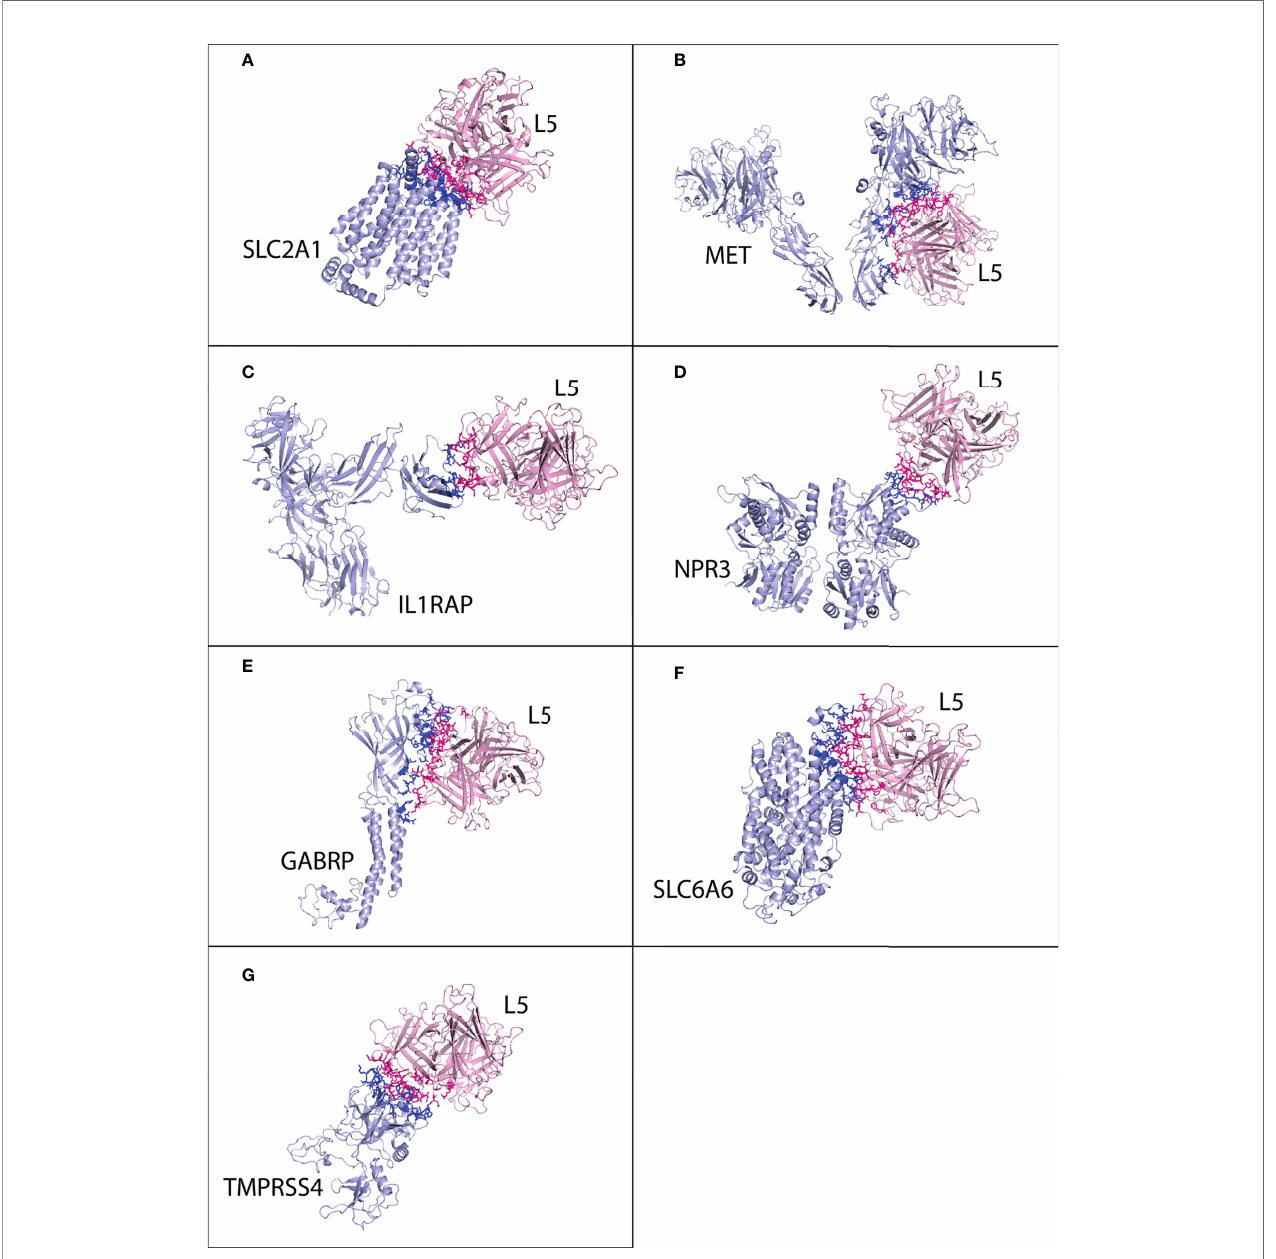
FIGURE 6 | Protein – protein interaction complex of HAdV5 L5 protein with pancreatic cancer receptors. The pink ribbon represents L5 protein, while purple ribbons represent cancer receptors. The interacting residues are shown by a stick, L5 protein is shown in dark pink, and receptor is shown in dark blue. (A) SLC2A1 made a total of 138 interactions. (B) MET made 93 interactions. (C) IL1RAP made 44 interactions. (D) NPR3 made 55 interactions. (E) GABRP made 114 interactions. (F) SLC6A6 made 129 interactions. (G) TMPRSS4 made 96